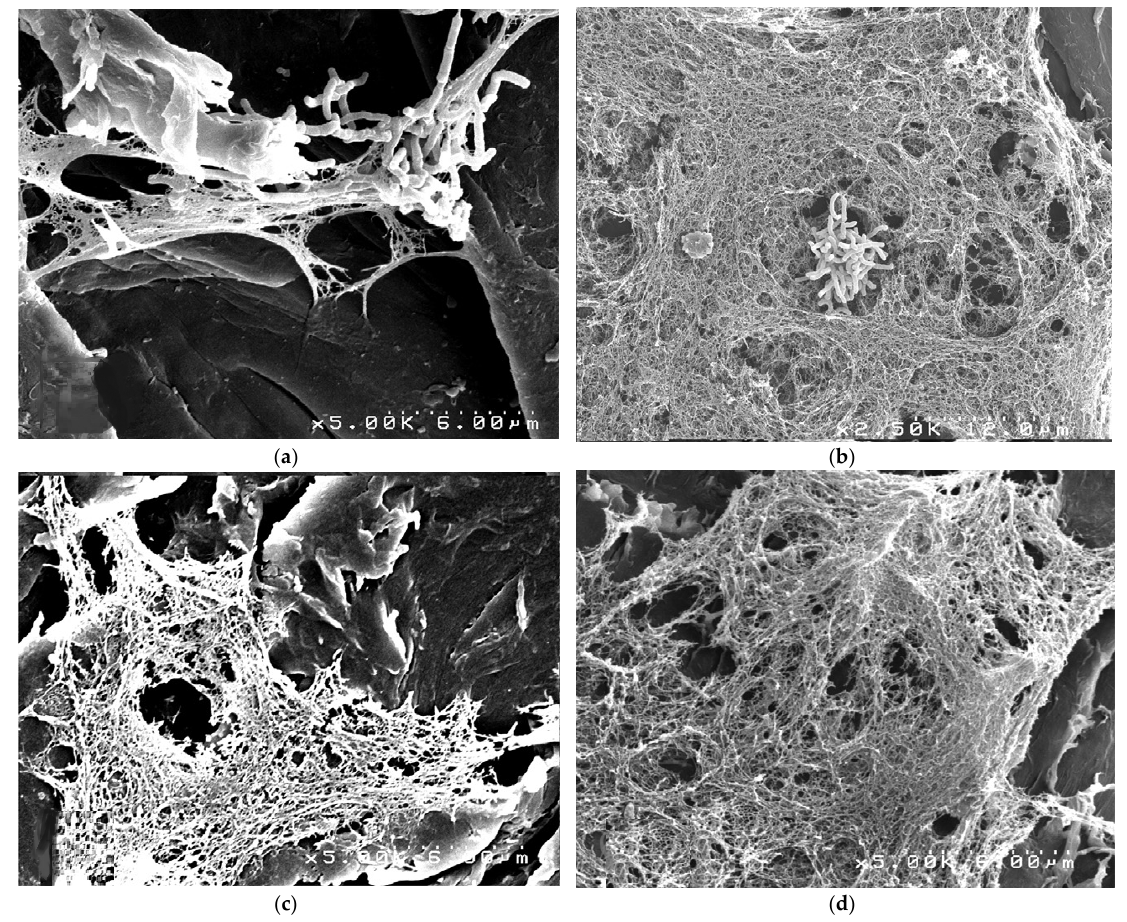
Figure 6 . Representative Scanning Electron Microscopy (SEM) biofilm images on PEEK. ( a ) 8 h, ( b ) 12 h, ( c ) 16 h and ( d ) 20 h of adhesion. Biofilm was observed to form on PEEK only. (Reproduced from [84], with permission from © 2020 Elsevier) .